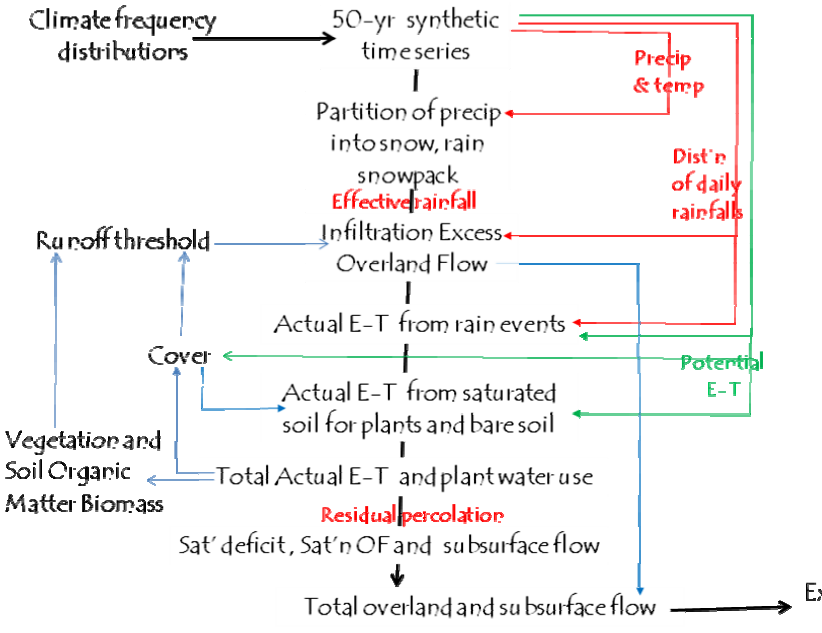
Figure 2. Fig. 2. Schematic for hydrological Schematic for hydrological model